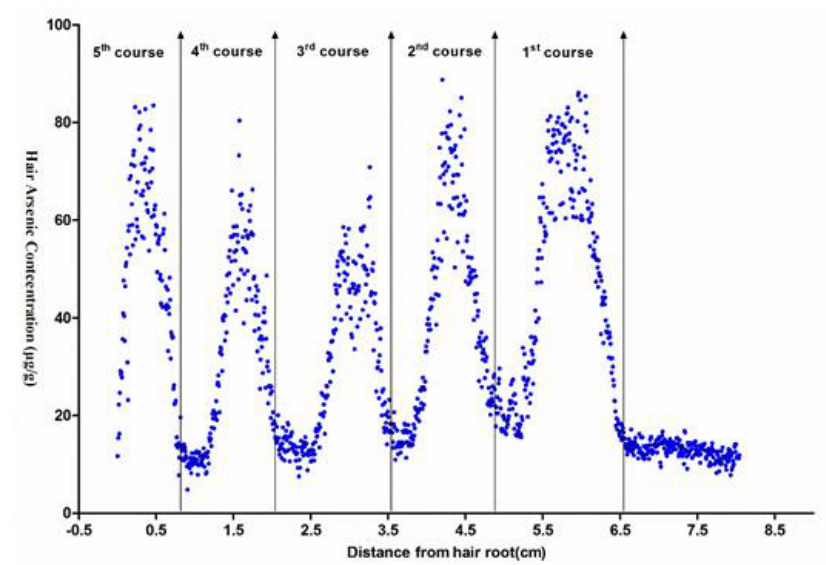
Figure 2. Arsenic exposure frequency for patient No. 1.